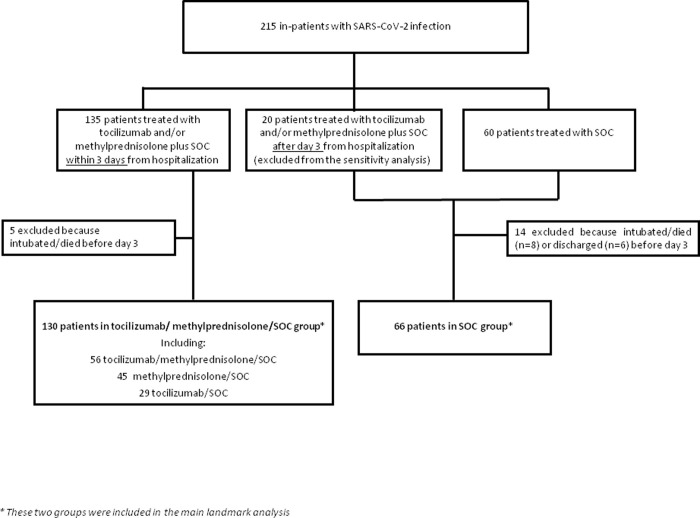
The flowchart of the included patients.